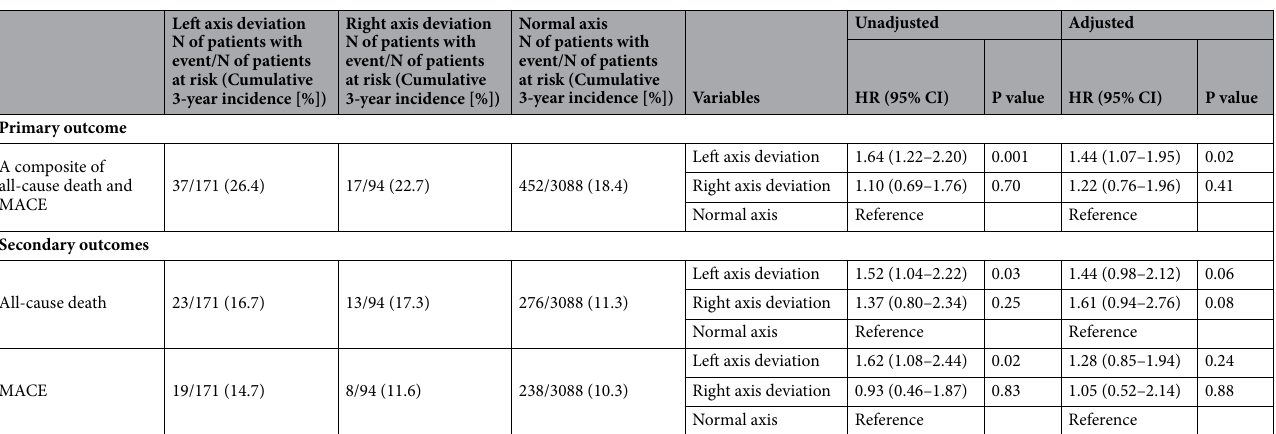
Table 2. Clinical outcomes of patients in each frontal plane QRS axis groups. CI confidence interval, HR hazard ratio, MACE major adverse cardiovascular events.